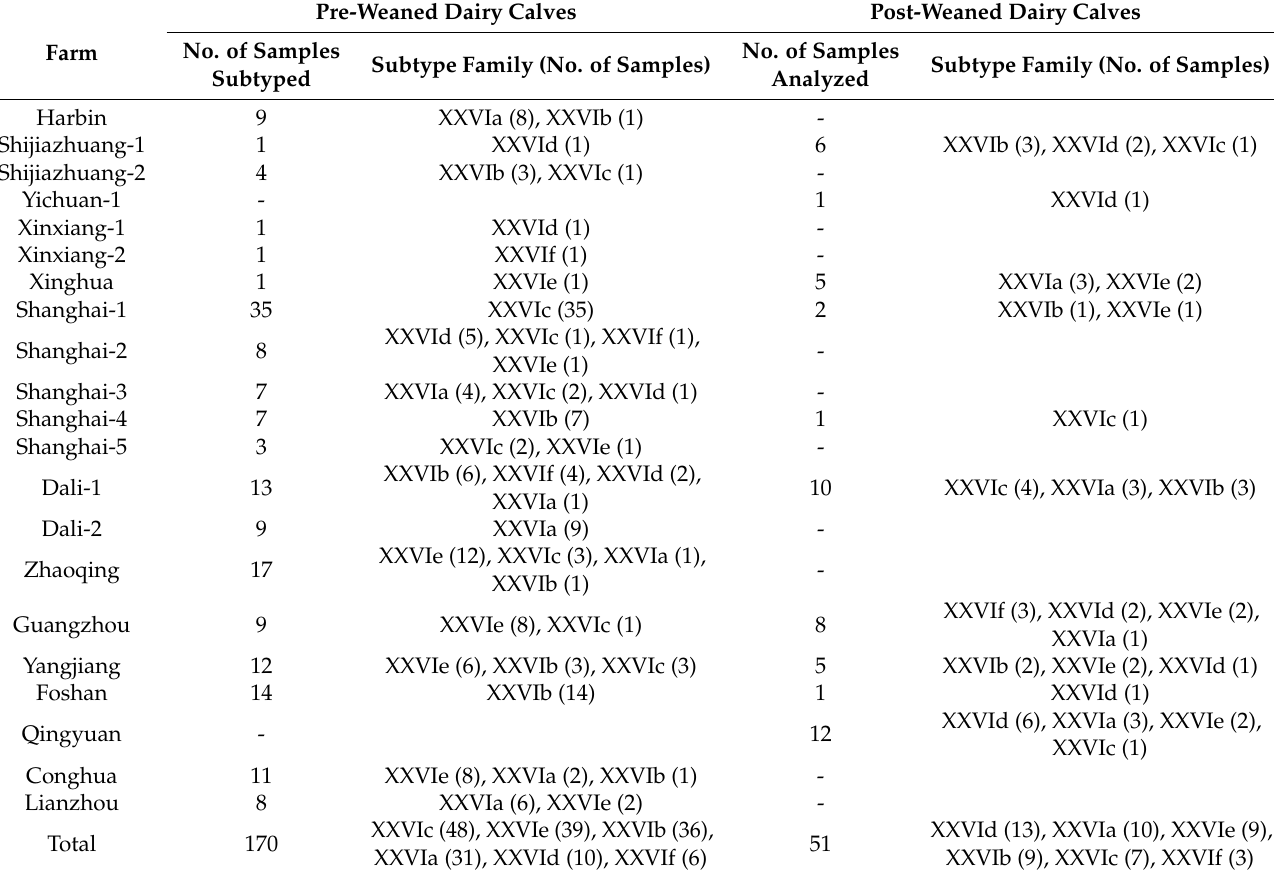
Table 3. Distribution of Cryptosporidium bovis subtype families at the gp60 locus in pre- and post-weaned dairy calves on study